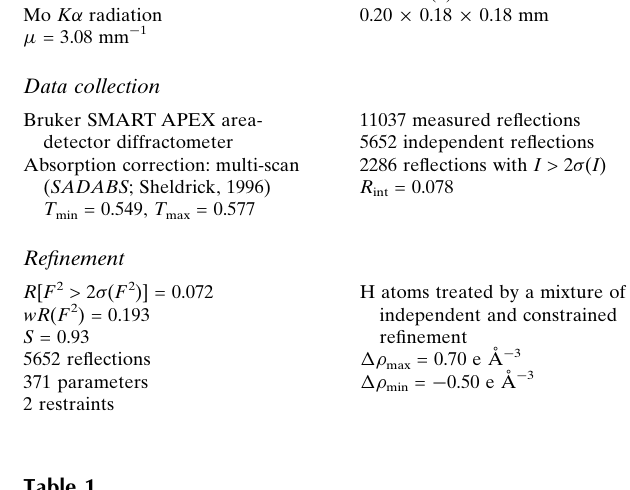
Hydrogen-bond geometry (A˚ , (cid:1)